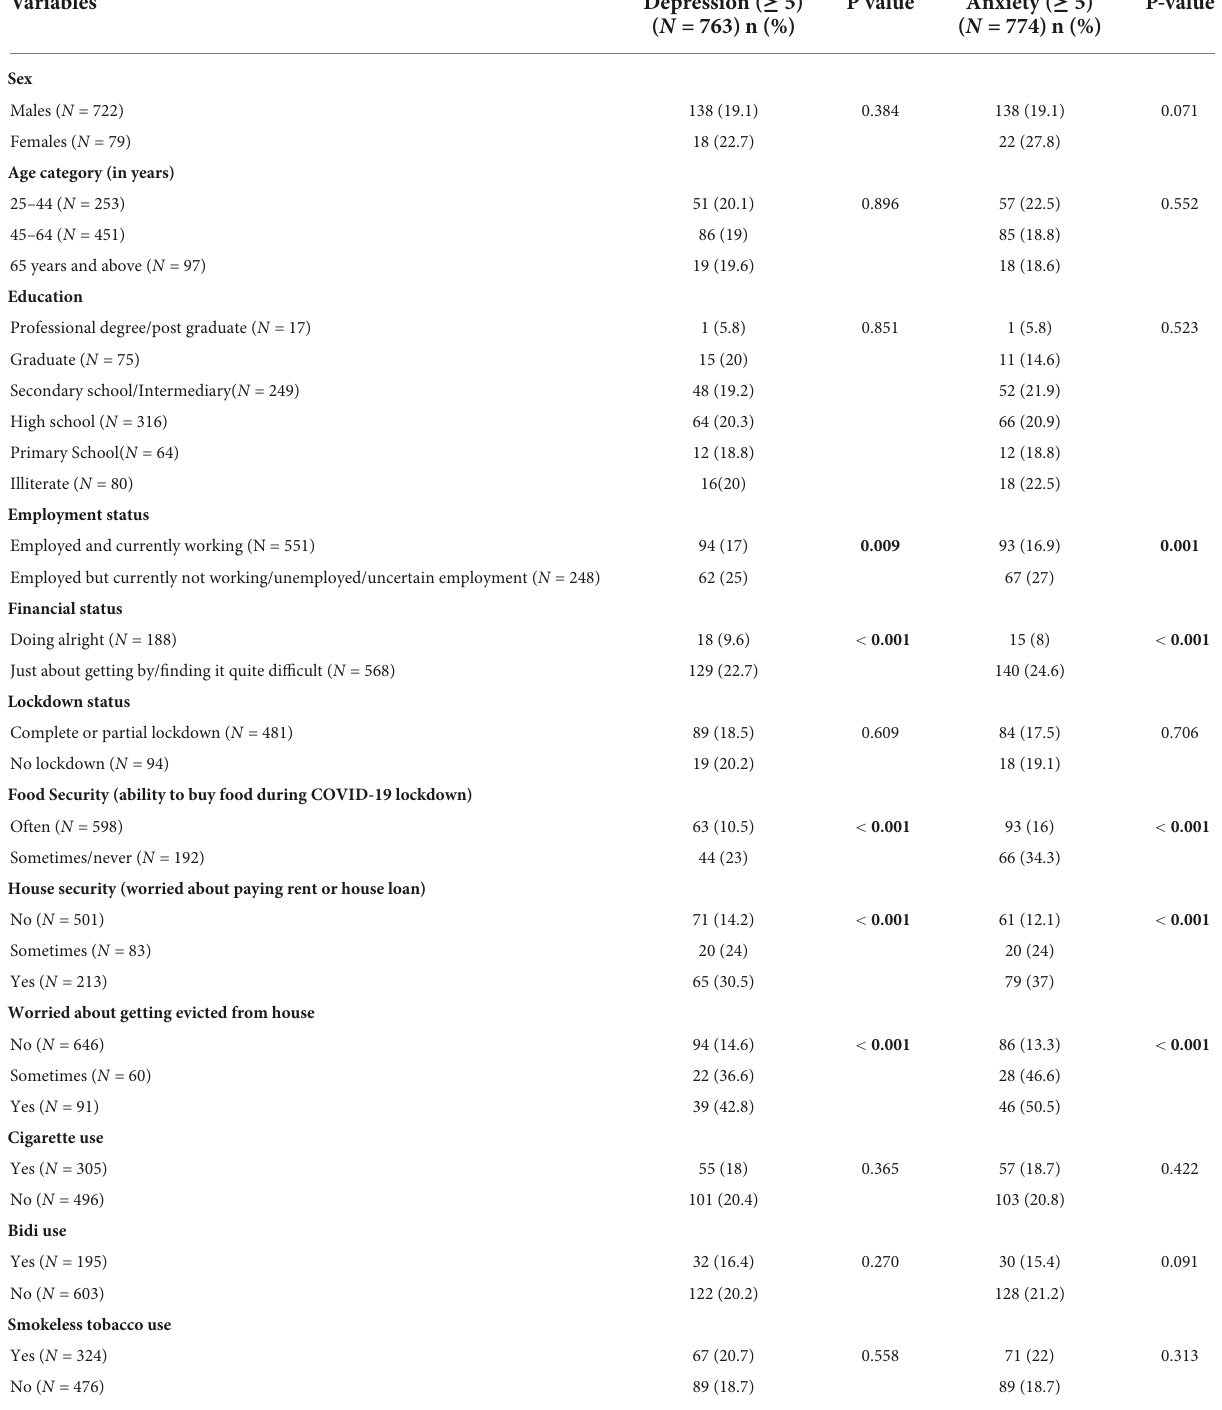
TABLE 2 Prevalence of depression and anxiety symptoms among tobacco